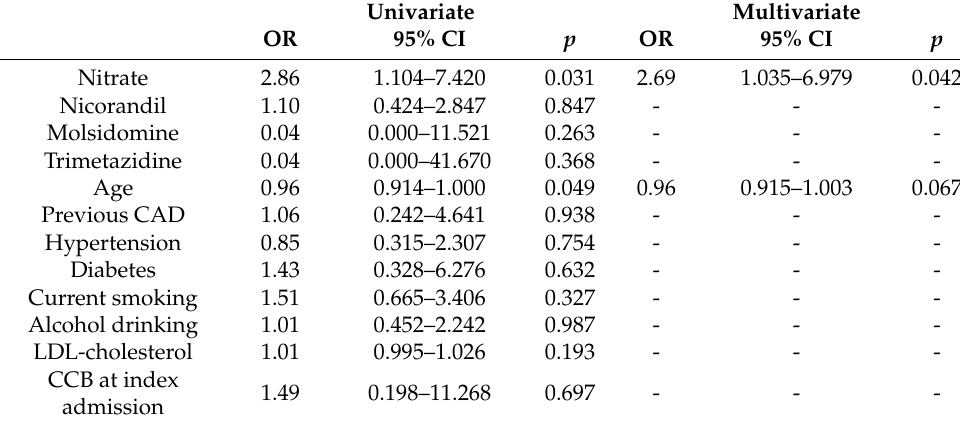
Table 4. Predictors of ACS in patients with